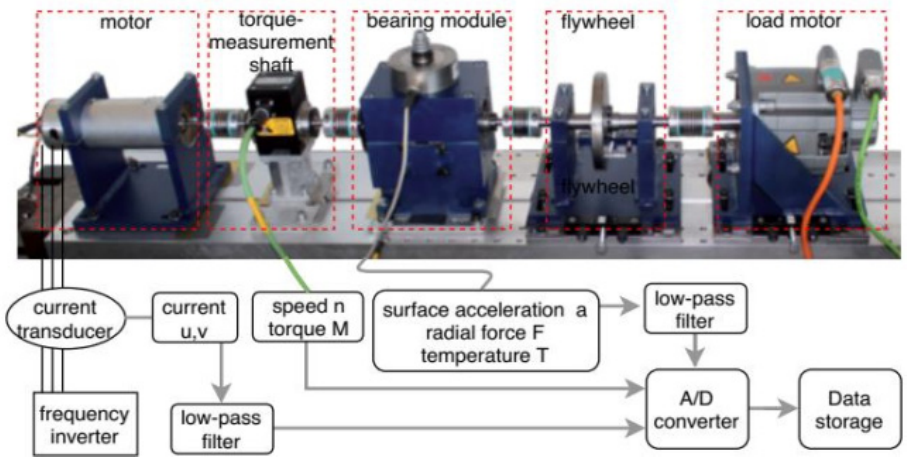
Figure 1. Schematic diagram of the test rig.